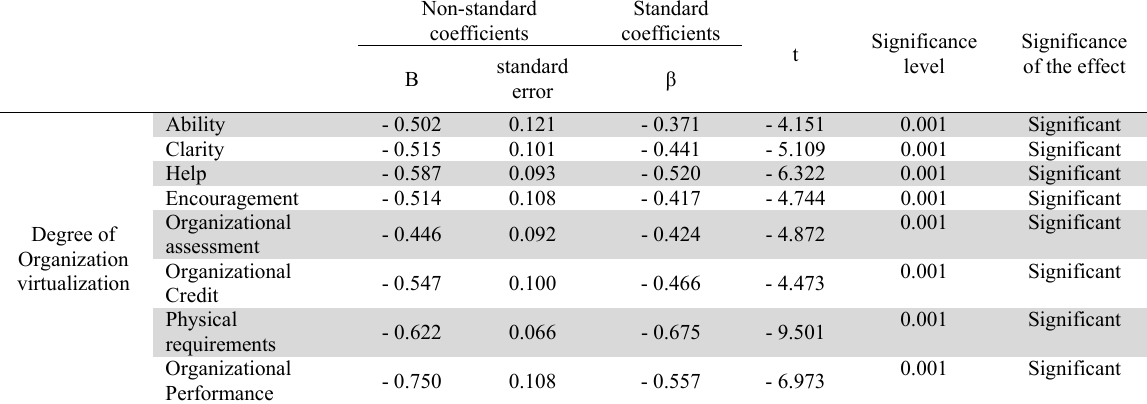
Results of regression analysis coefficients of each of the variables in the model in the fit of dependent